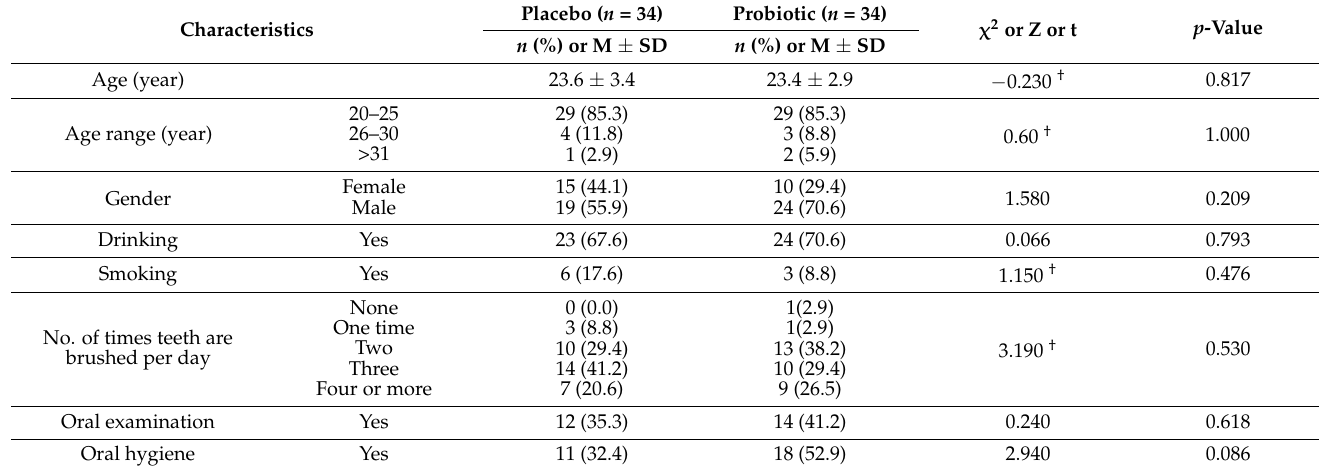
Table 1. Baseline characteristics of the subjects in the probiotic and placebo groups ( n = 68).